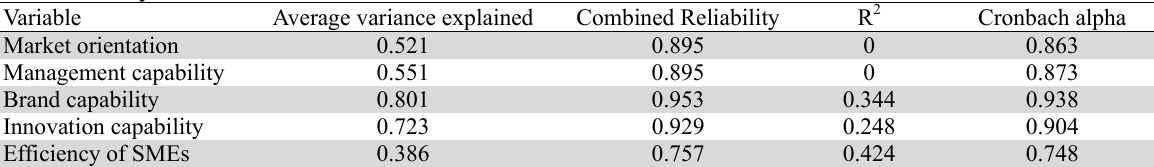
The summary of some basic statistics